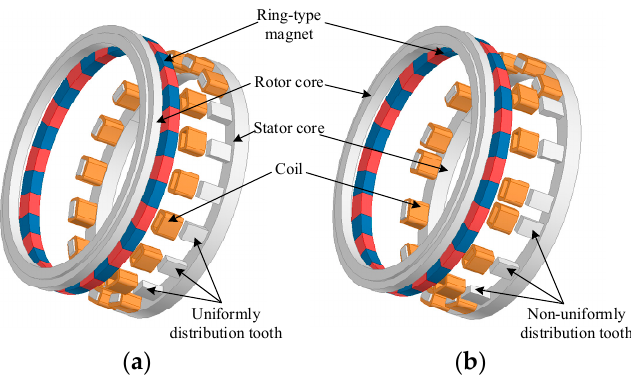
Figure 1. Configuration of the proposed AFPMVM: ( a ) regular topology ( b ) proposed topology. Table 1. Machine parameters and